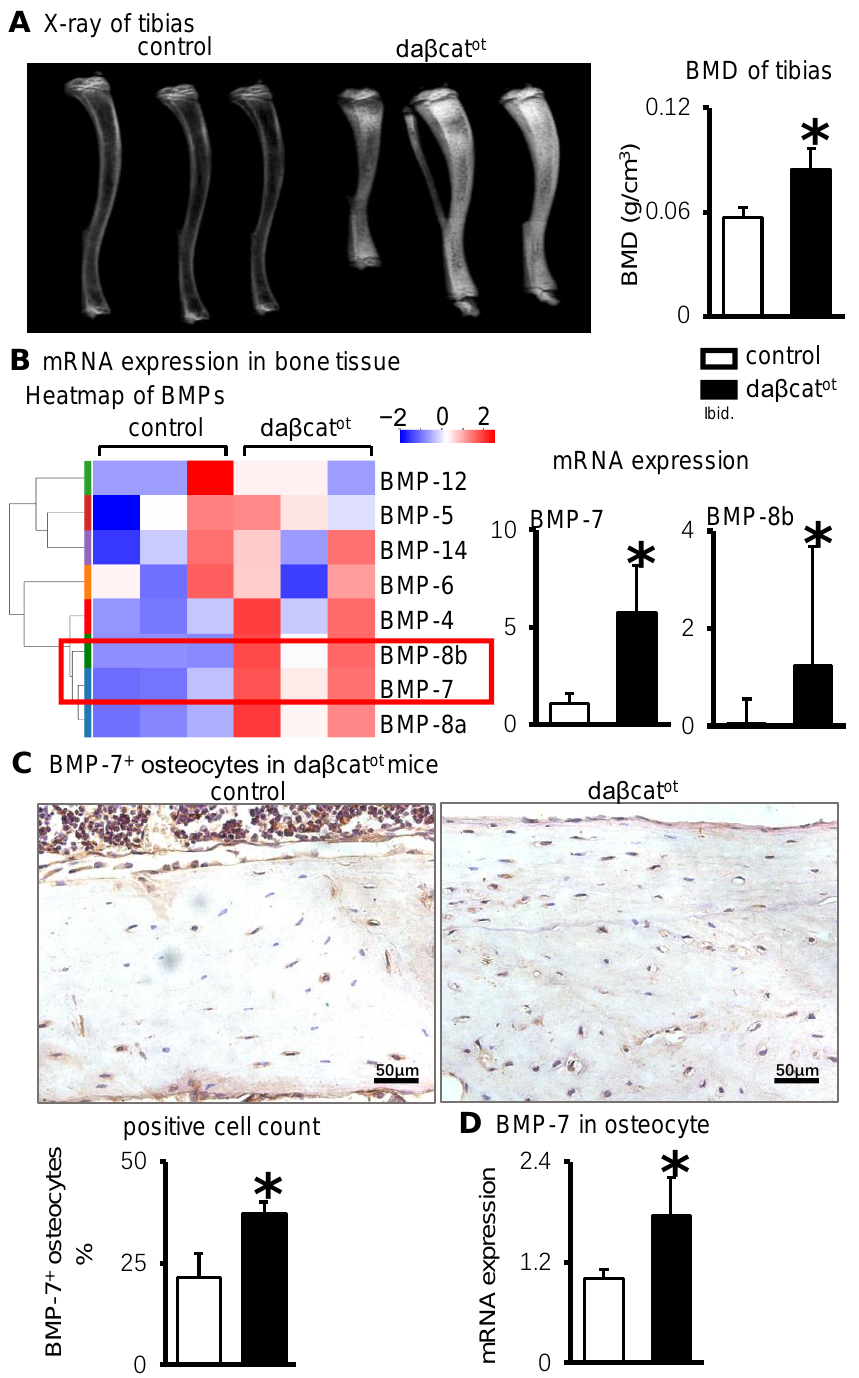
Figure 1. BMP-7 expression in bone tissue and osteocytes of da β cat ot mice. ( A ). X-ray images and BMD quantification results. ( B ). Cluster analysis heat map of BMP signal in fractured tibial bone tissue of da β cat ot mice and differential gene expression of BMP-7, two significantly increased genes are in the red box. ( C ). Immunohistochemical staining of BMP-7 in osteocytes and quantitative analysis of BMP-7-positive osteocytes in tibial cortical bone of da β cat ot mice. ( D ). RT-qPCR analysis of BMP-7 gene expression in primary osteocytes of da β cat ot mice. * p < 0.05, compared with control group.